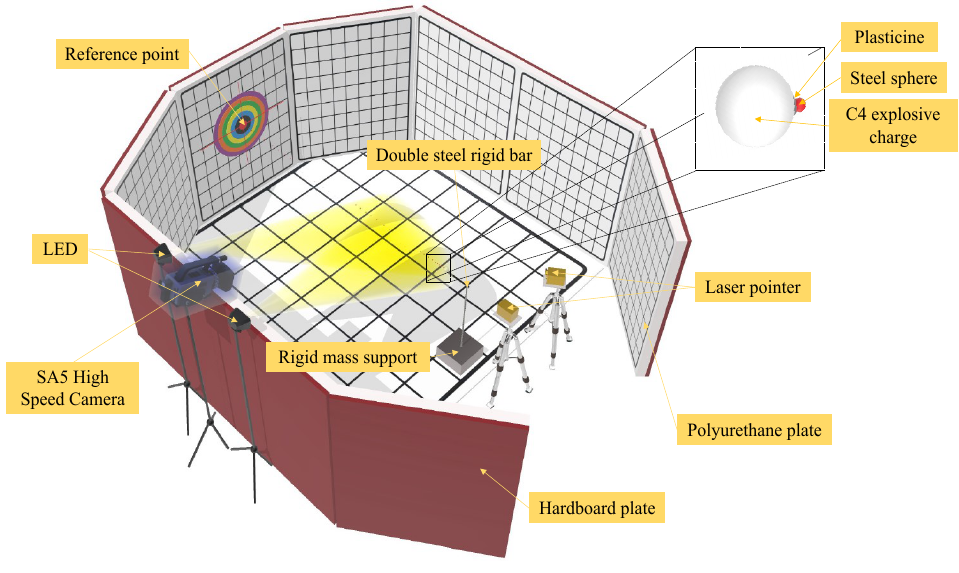
Figure 3. Schematic representation of the experimental setup showing the different instruments used to track the projectile flight trajectory.